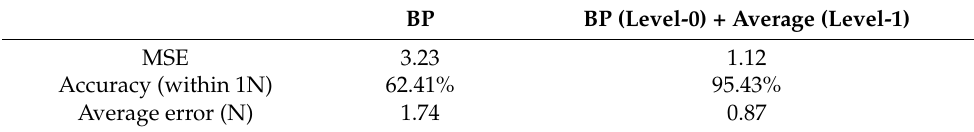
Figure 13. Identification results of peak values using ensemble learning. Table 3. Comparison of peak value identification results in BP and ensemble